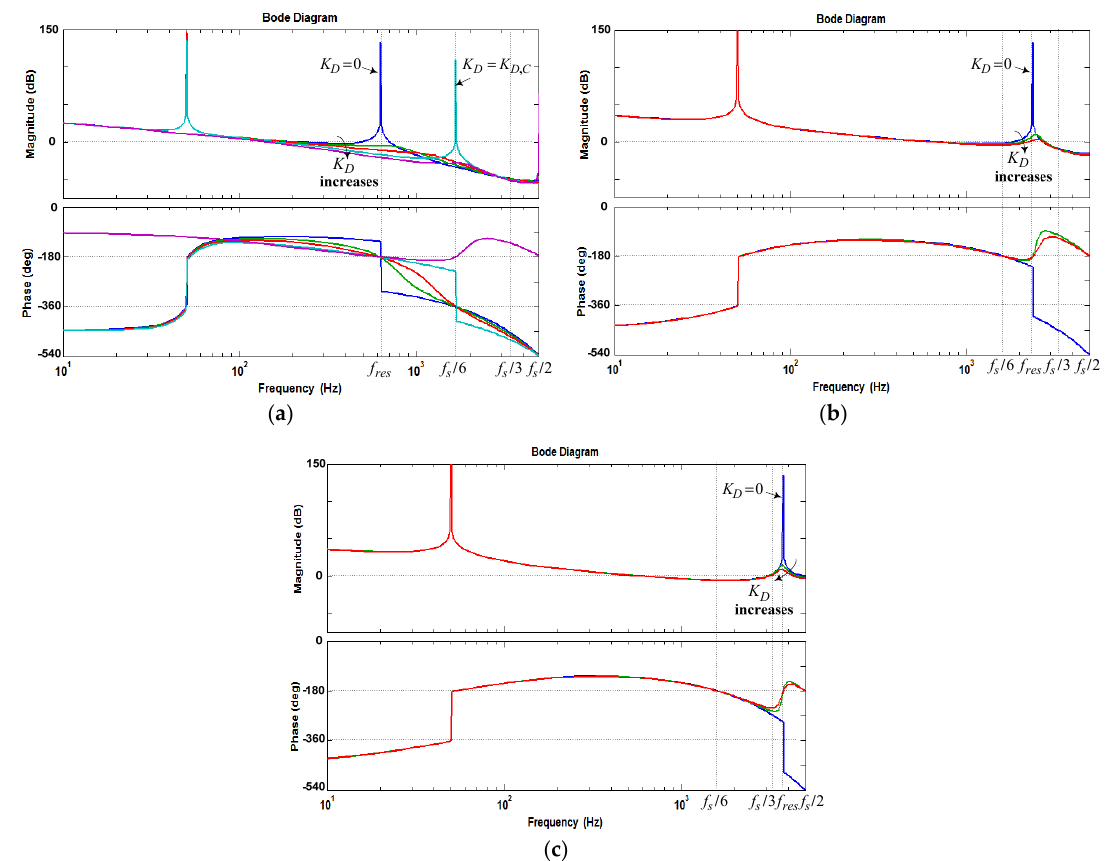
Figure 10. Bode plots of the open-loop gain in the grid-side current control scheme with proportional CCF AD method: ( a ) f res < f s /6; C f = 36 μ F; K p = 0.0261; K i = 3.0769; ( b ) f s /6 < f res < f s /3; C f = 2.5 μ F; K p = 0.0991; K i = 44.3077; and ( c ) f s /3 < f res < f s /2; C f = 1 μ F; K p = 0.1566; K i = 110.7692.